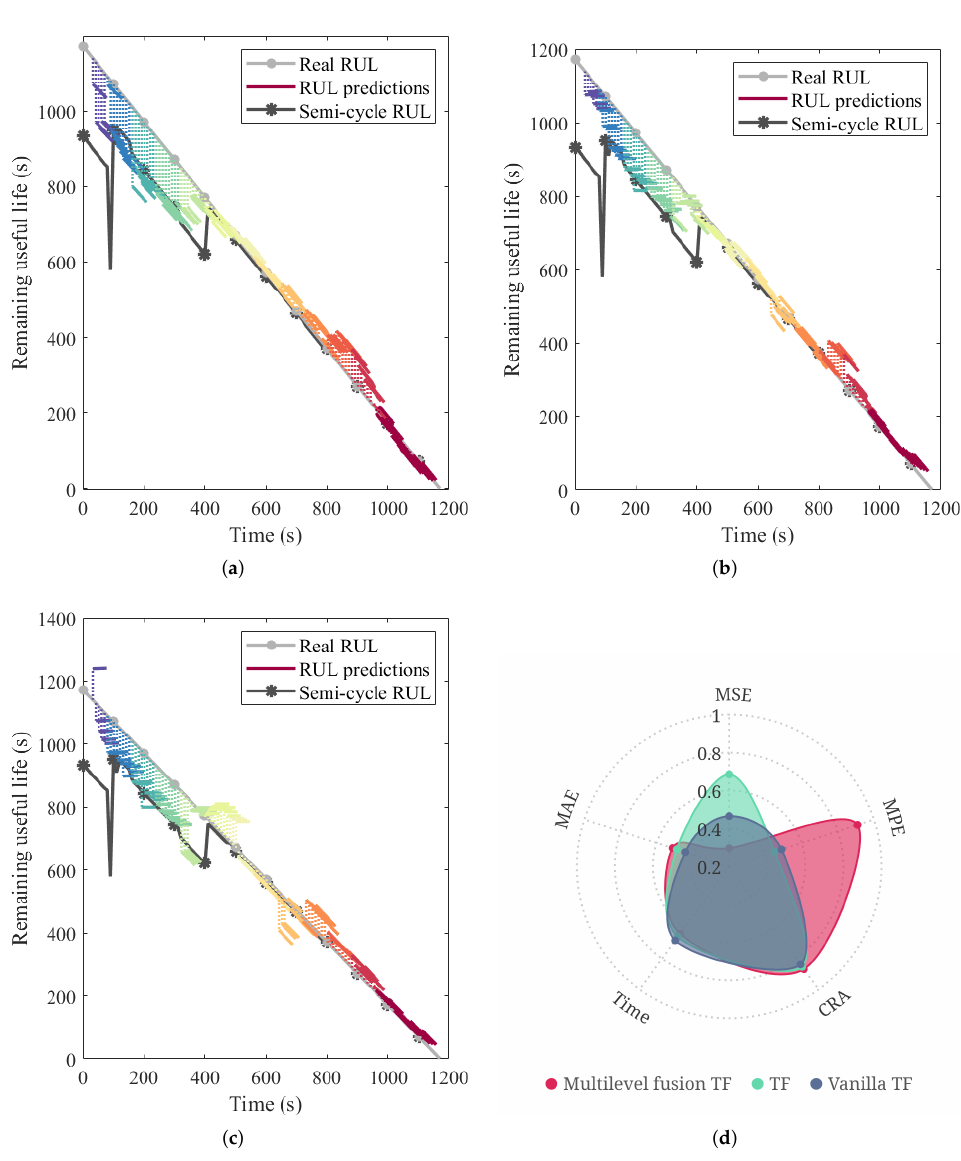
Figure 9. Predictions for the next 48 s. ( a ) RUL predictions of the multilevel fusion transformer network. ( b ) RUL predictions of the transformer network. ( c ) RUL predictions of the vanilla transformer network. ( d ) The 5-dimensional radar chart for the performance comparison of the aforementioned prediction methods. The performance depicted in the radar chart ranges from 0 to 1 (from low to high). The colored solid line represents the output value of the RUL prediction sequence in the next 48 s. The point corresponding to the colored dotted line refers to the RUL prediction start time. The network needs to obtain data from 32 s before the start time of the current time as an input. As a result, the RUL is predicted every 10 s after the 32 s blank period to meet the maneuver decision-making needs for the full